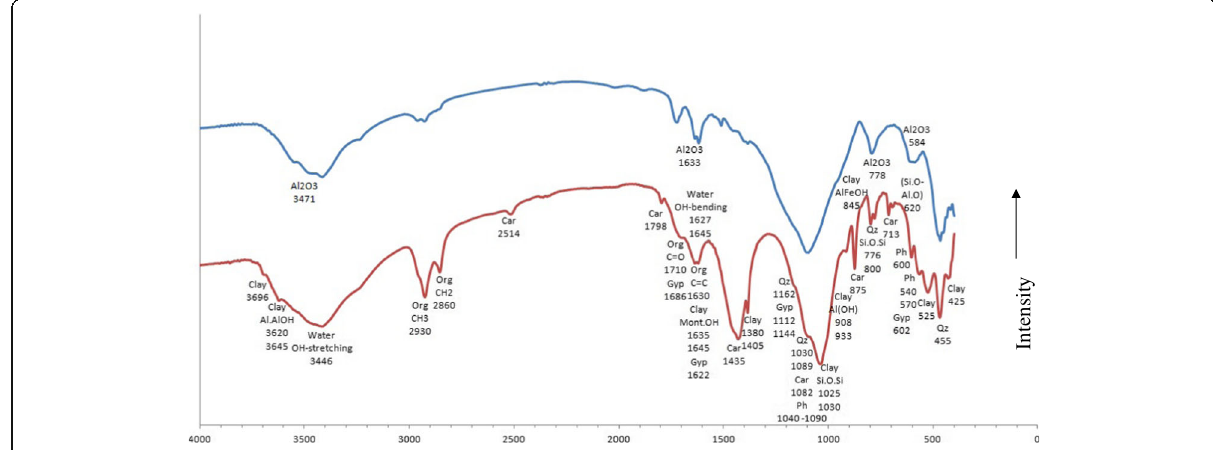
Fig. 5 FTIR spectra recorded for raw clay technological sample (down) and the fired sample